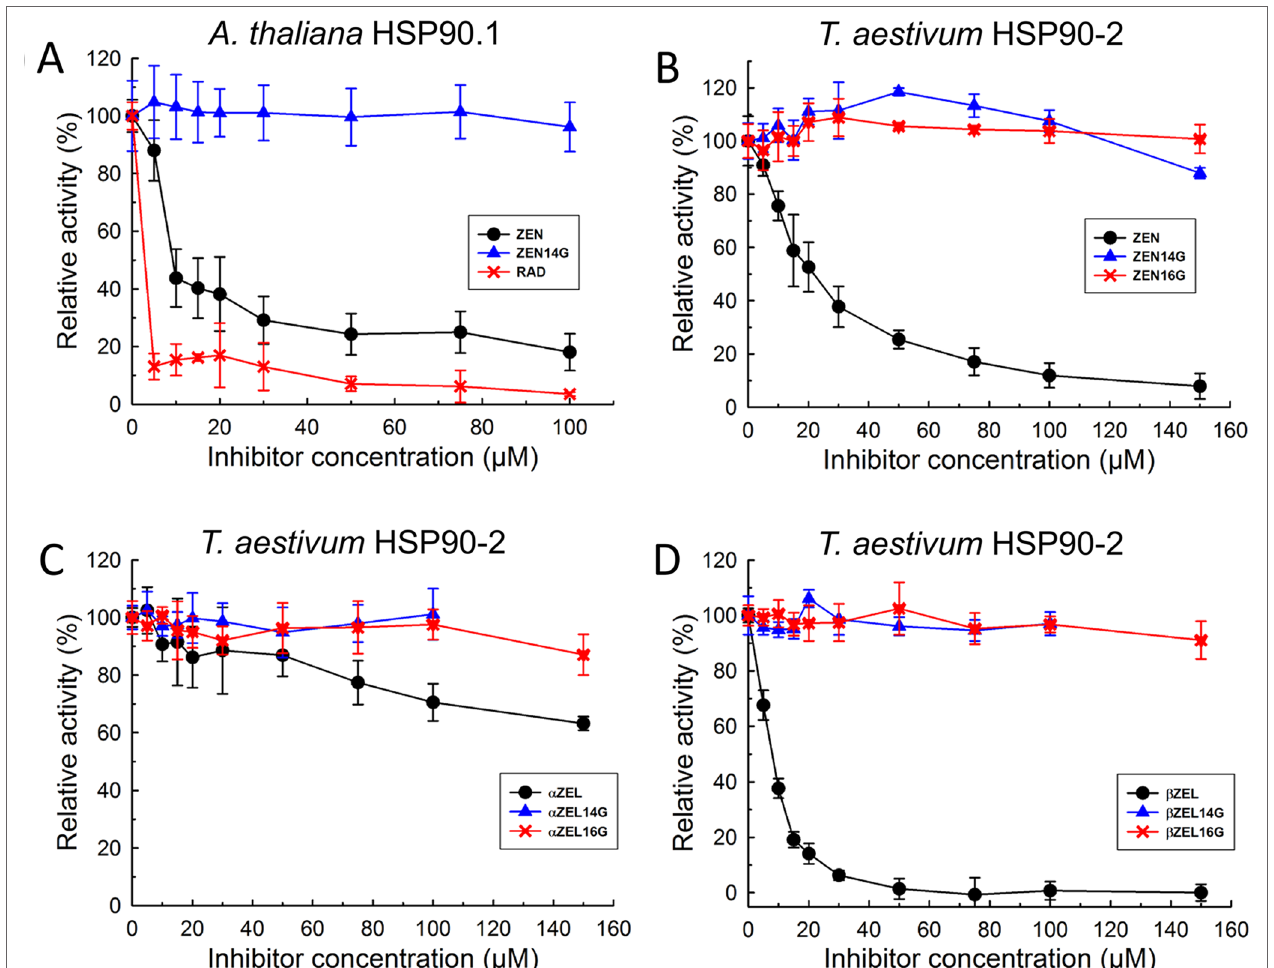
FIGURE 4 | Inhibition of Arabidopsis thaliana HSP90.1 (A) and Triticum aestivum HSP90-2 (B – D) ATPase activity by RAD, ZEN, zearalenone-14-glucoside (ZEN14G), zearalenone-16-glucoside